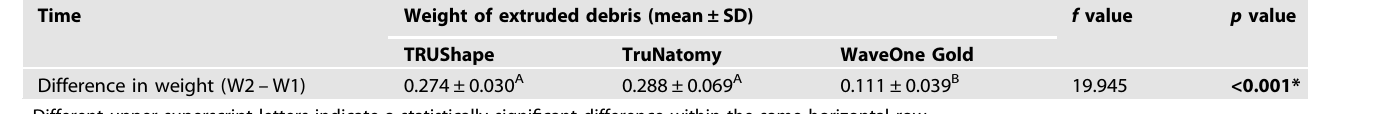
Table 1. Mean and standard deviation (SD) values for the weight of extruded debris